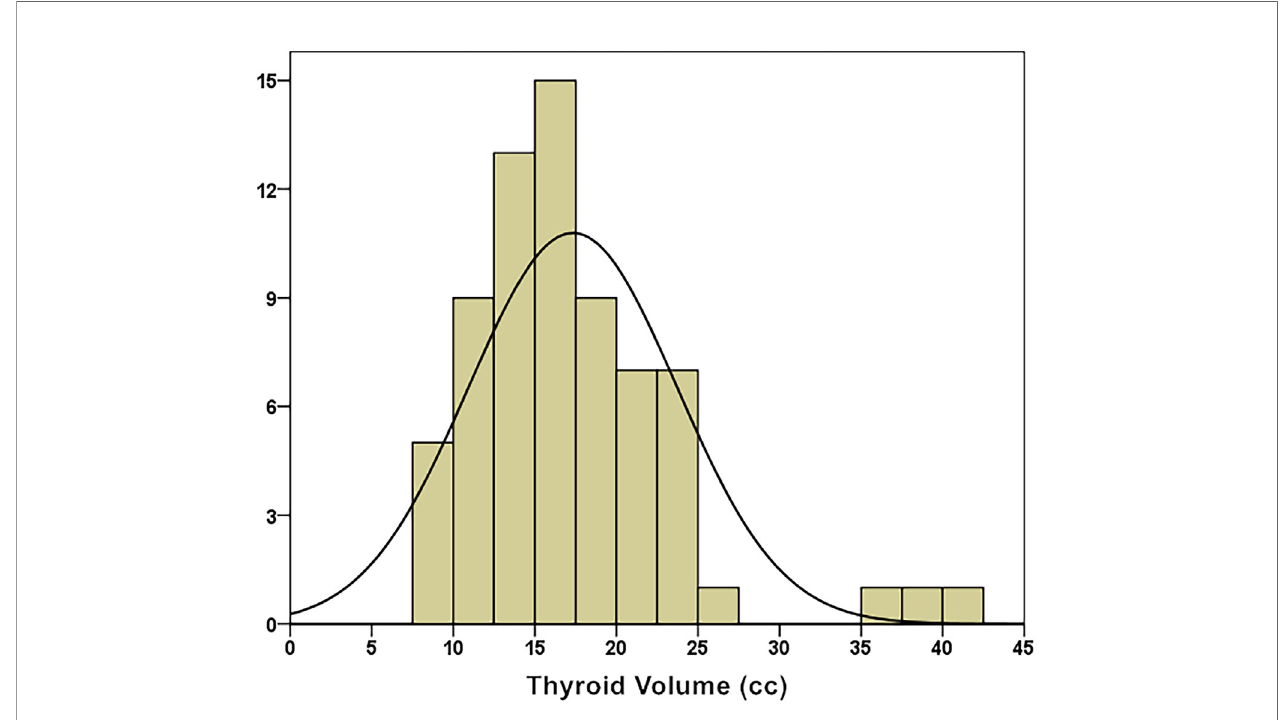
FIGURE 2 | Thyroid volume distribution of 69